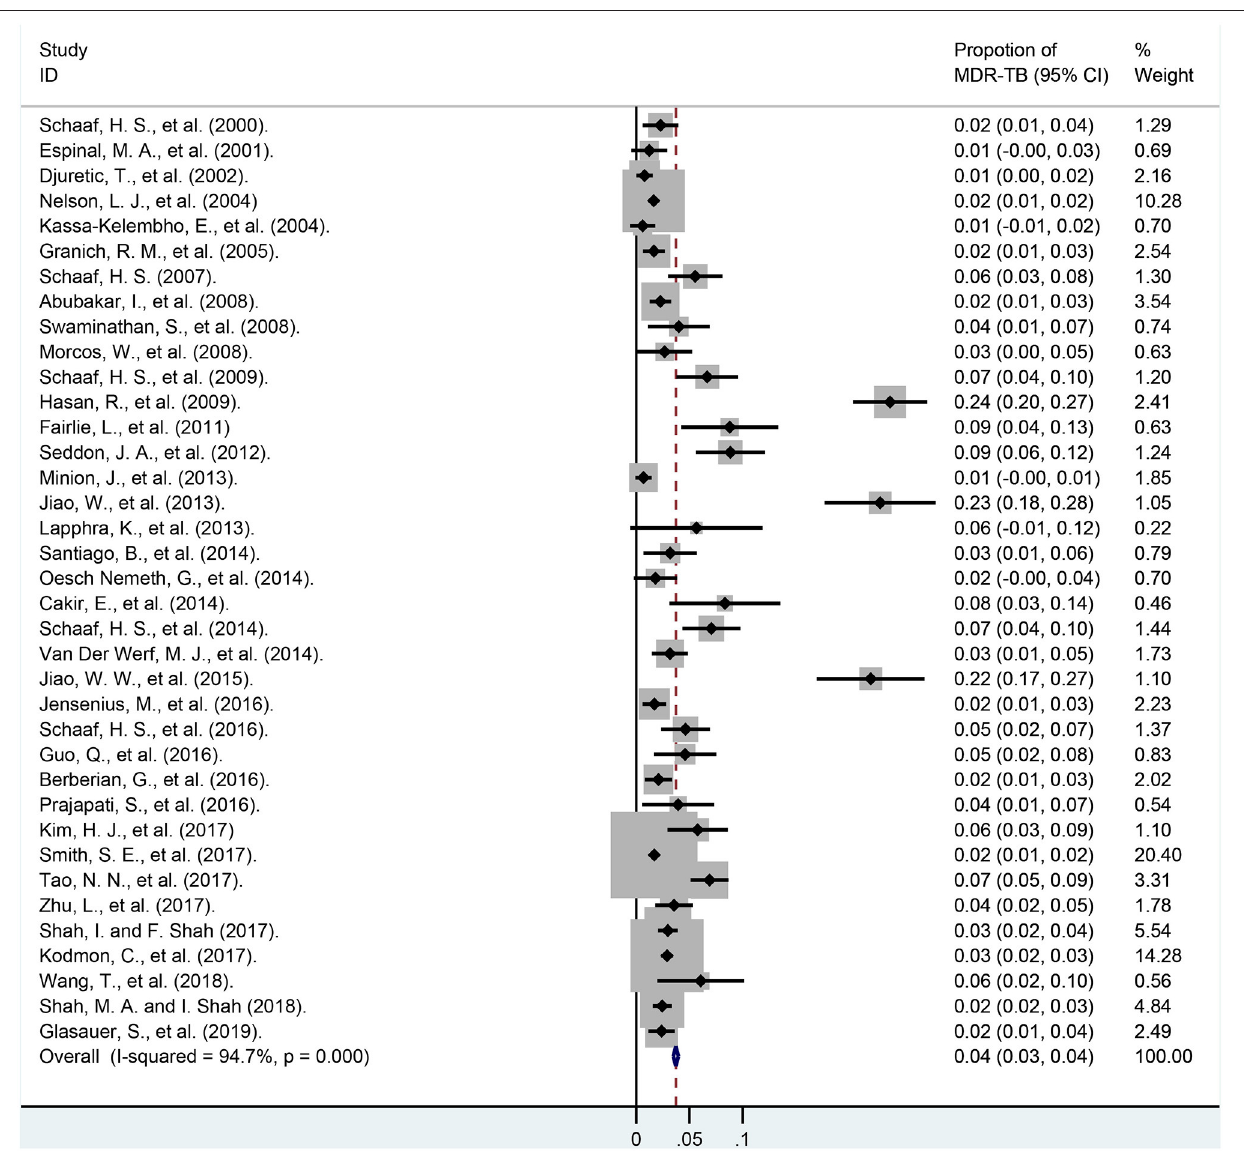
FIGURE 3 | Forest plot depicting the pooled proportion of multidrug-resistant tuberculosis in children. MDR-TB, multidrug resistant tuberculosis; Horizontal lines represent the 95% CIs around the point estimates for each study and the gray shaded areas are proportional to the weight given to each